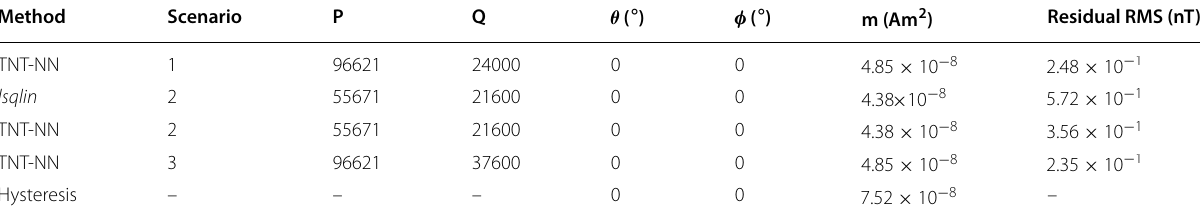
Table 3 Summary of the unidirectional ferromanganese crust inversion parameters and results